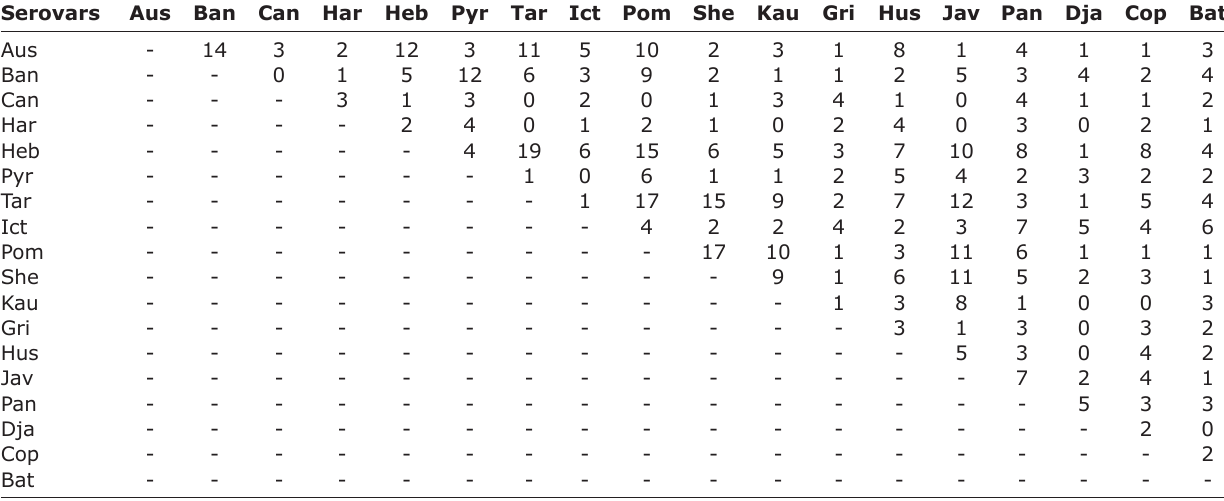
Table-3: Cross-reactivity among different Leptospira serovars in cattle and buffaloes in endemic districts of Andhra Pradesh.